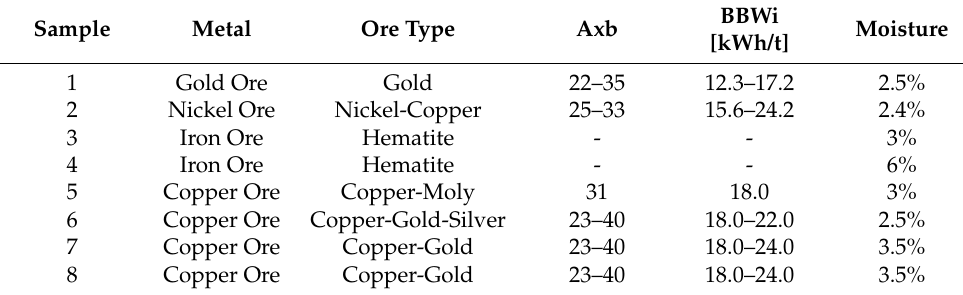
Table 1. Ores used for HPGR and PPT